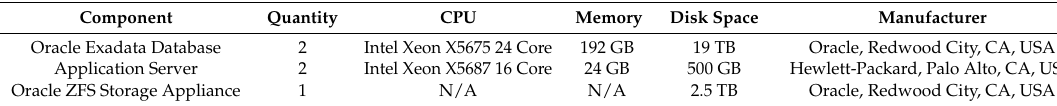
Table 2. Mayo Oracle TRC production hardware.